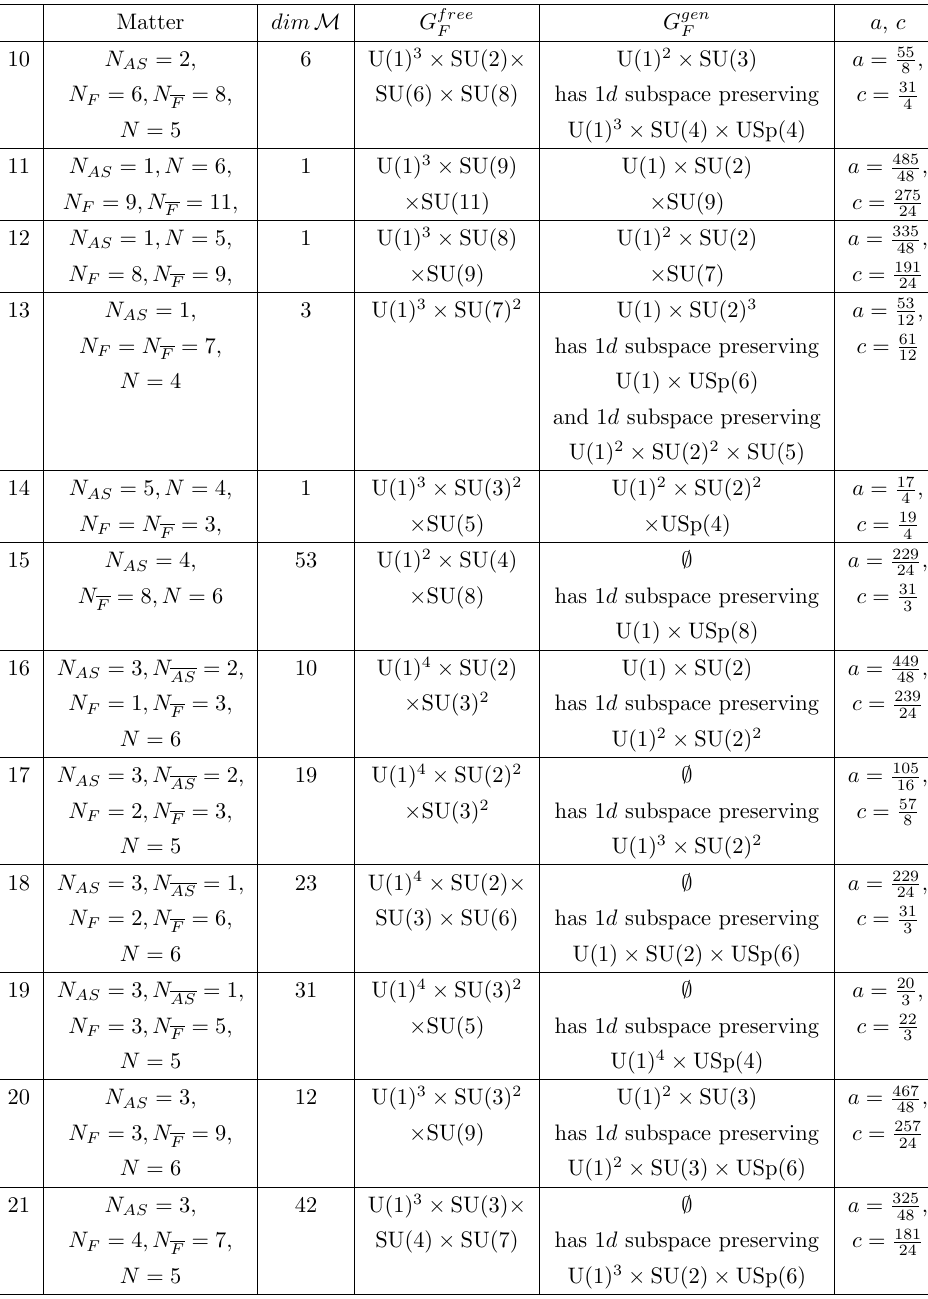
Table 4 . Cases involving an SU( N ) gauge group with one adjoint chiral (cid:12)eld, continued.